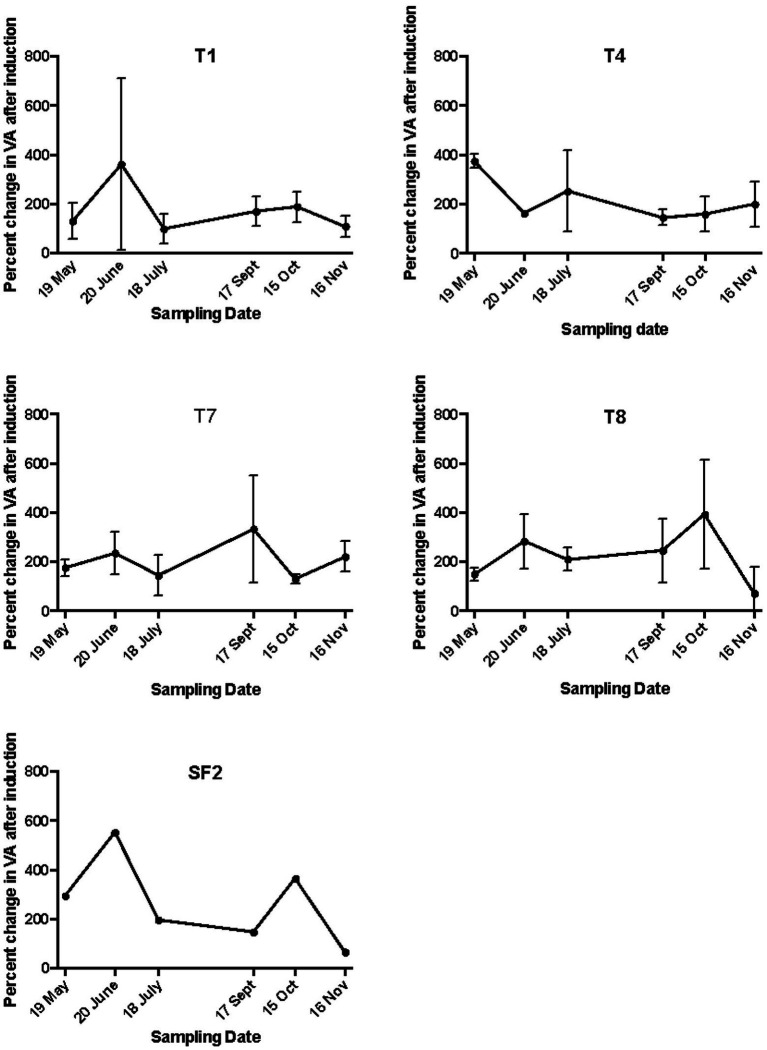
The percent increase in viral abundance (VA) in mitC-induced samples. The land management treatments are the same as described in Figure 1.